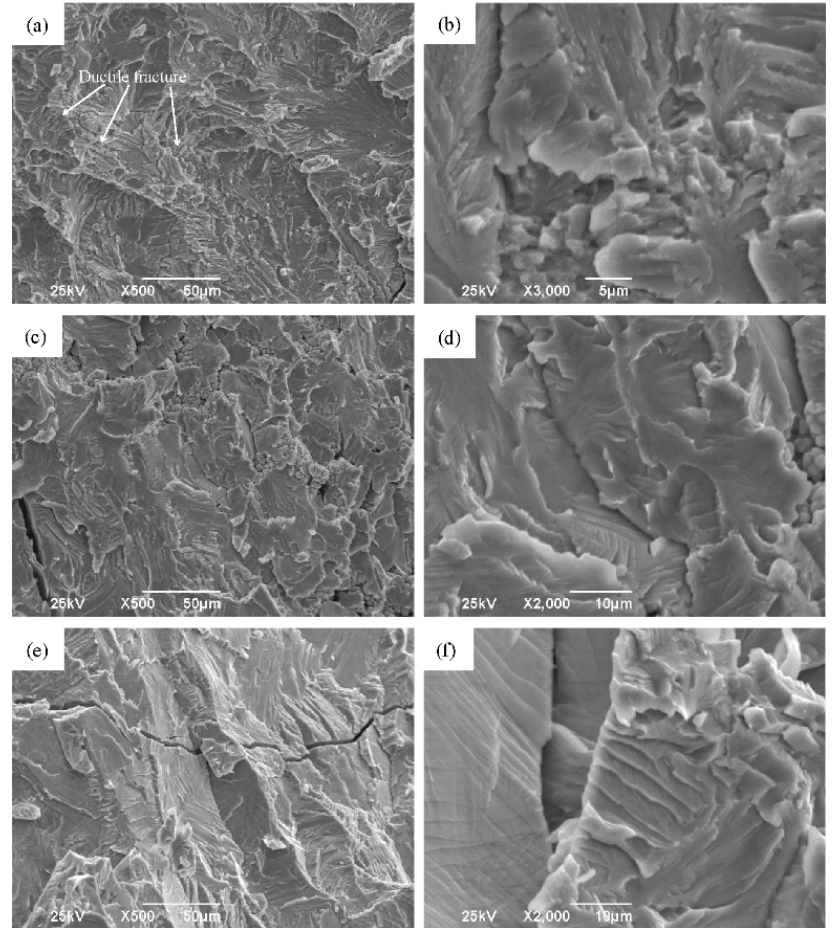
Figure 9. Fracture morphology of as-cast Ti–Fe–Sn–Mo alloys. ( a , b ) Ti 75 Fe 19 Sn 5 Mo 1 , ( c , d ) Ti 75 Fe 17 Sn 5 Mo 3 , ( e , f ) Ti 75 Fe 15 Sn 5 Mo 5 .